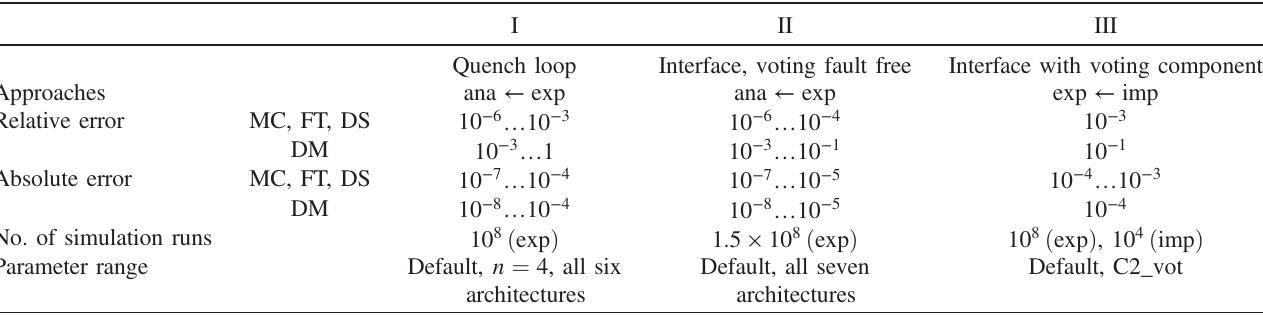
TABLE IX. Verification performed for studies I, II, and III (at least two approaches implemented). For the quench loop, for example, analytical calculations were verified with explicit simulations. Relative and absolute errors are reported for each of the four presented scenarios (Mission Completed, False Trigger, Demand Success, and Demand